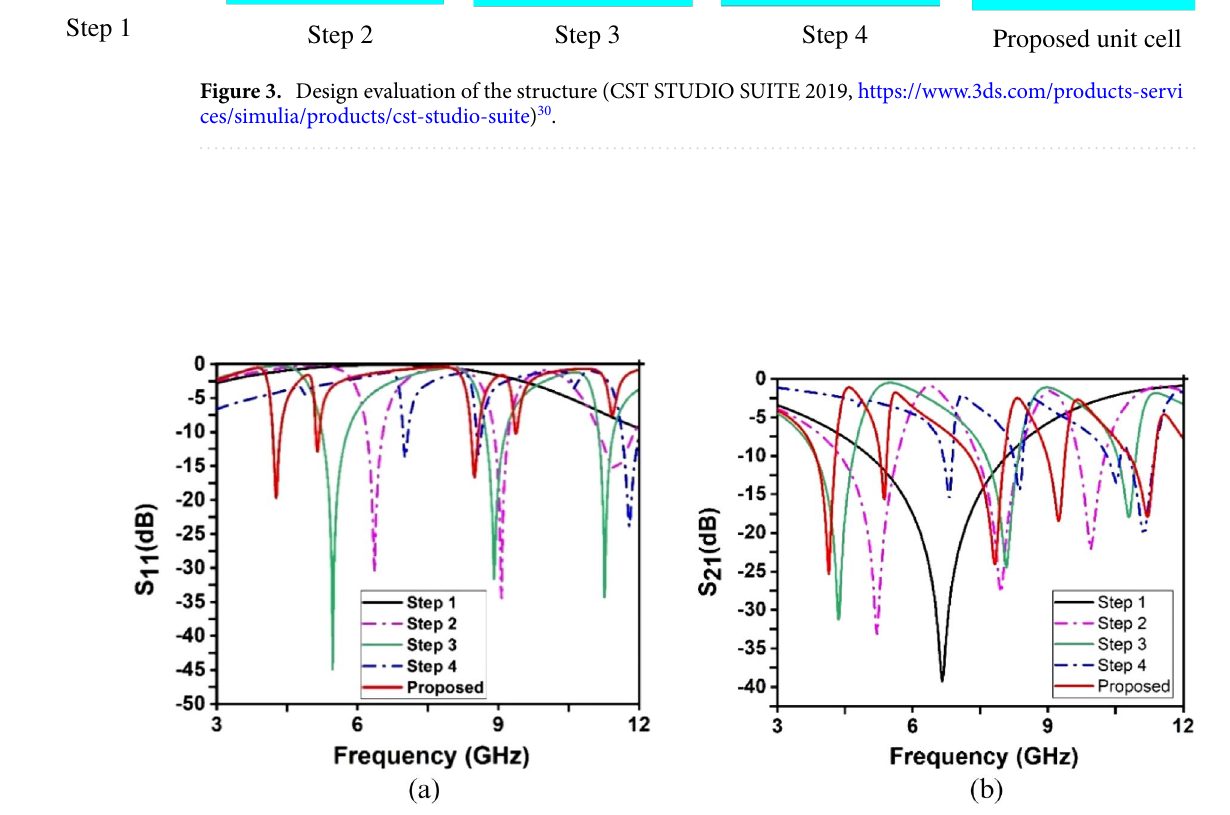
Figure 4. Scattering parameters of evolution steps toward the designed metamaterial unit cell: ( a ) reflection coefficient